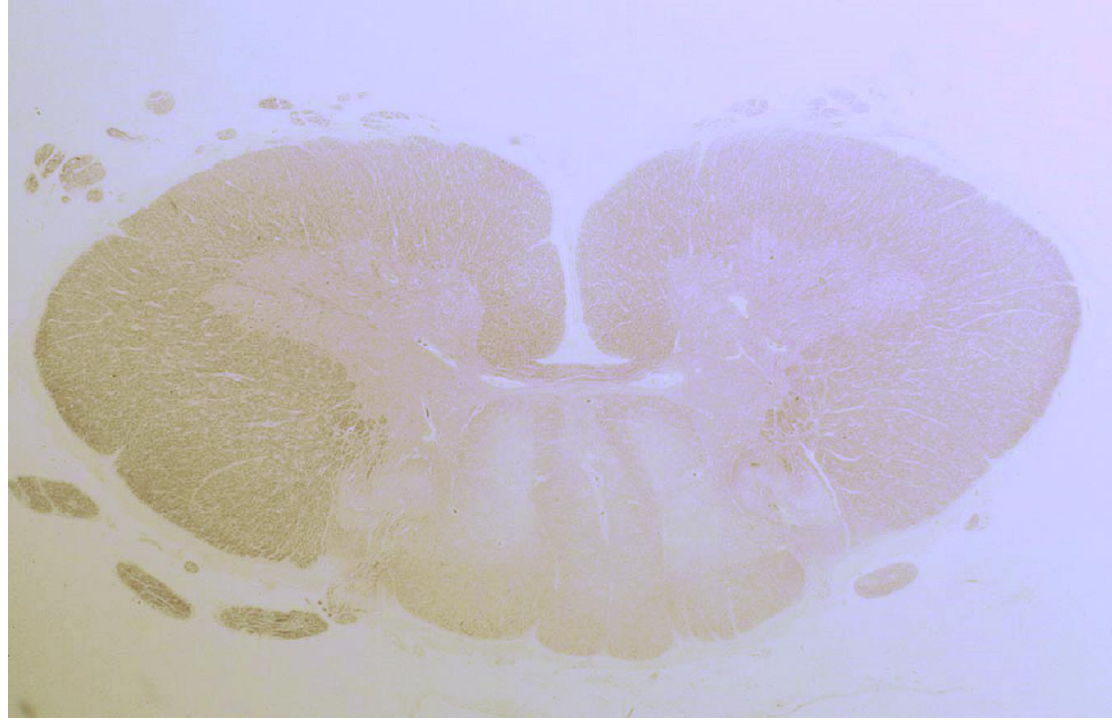
Figure 3. Degeneration (loss of tissue and a pale appearance) of the posterior column of the spinal cord in a patient with gluten ataxia and sensory ganglionopathy.